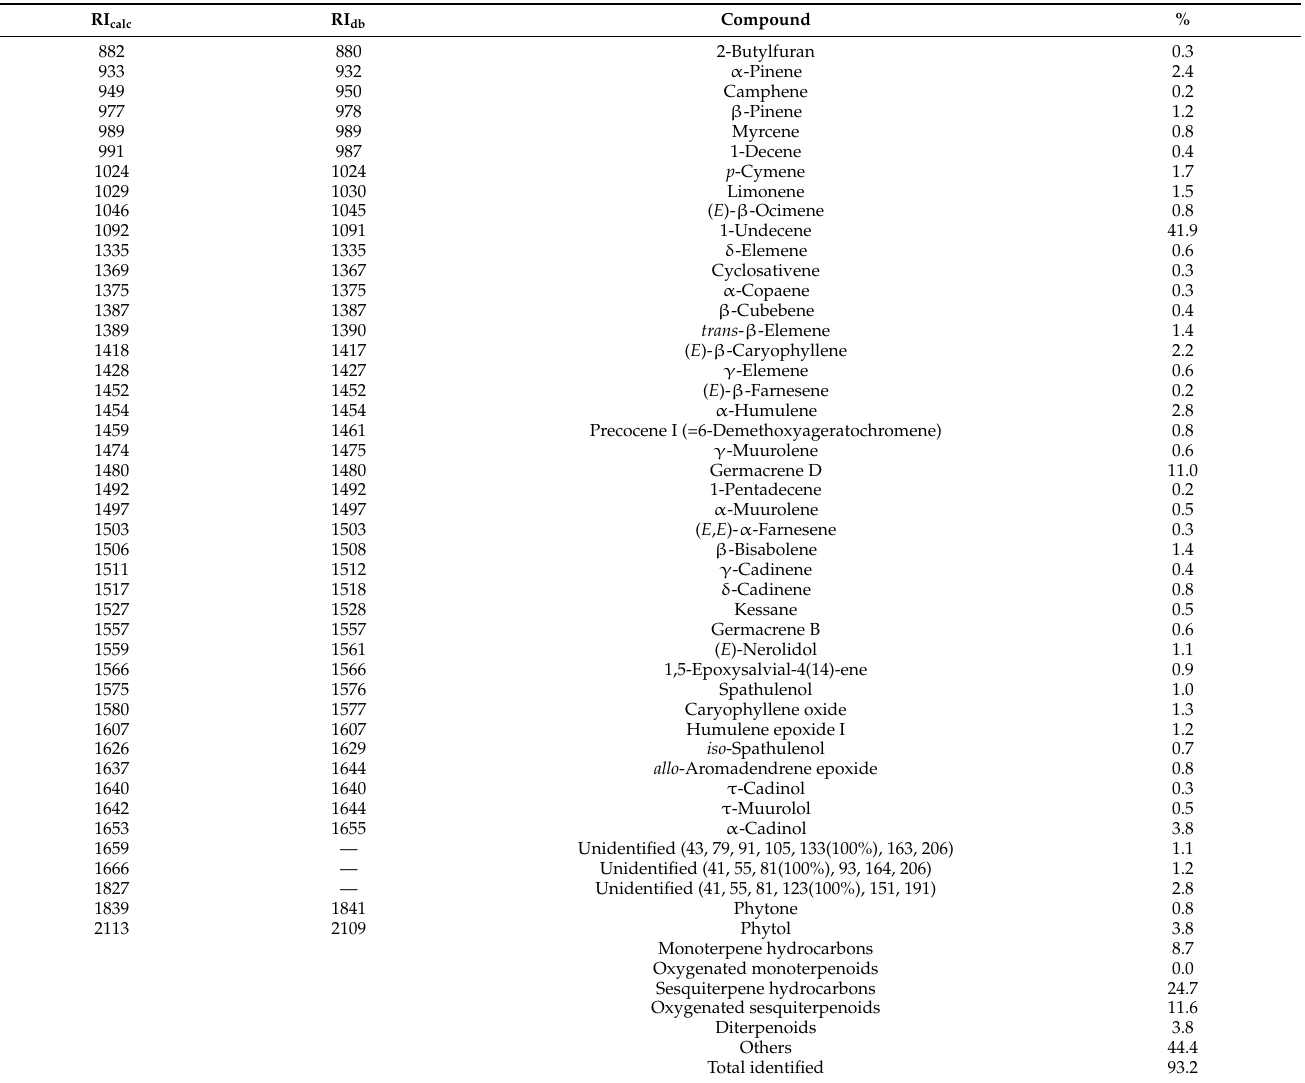
Table 3. Essential oil composition of Emilia sonchifolia from